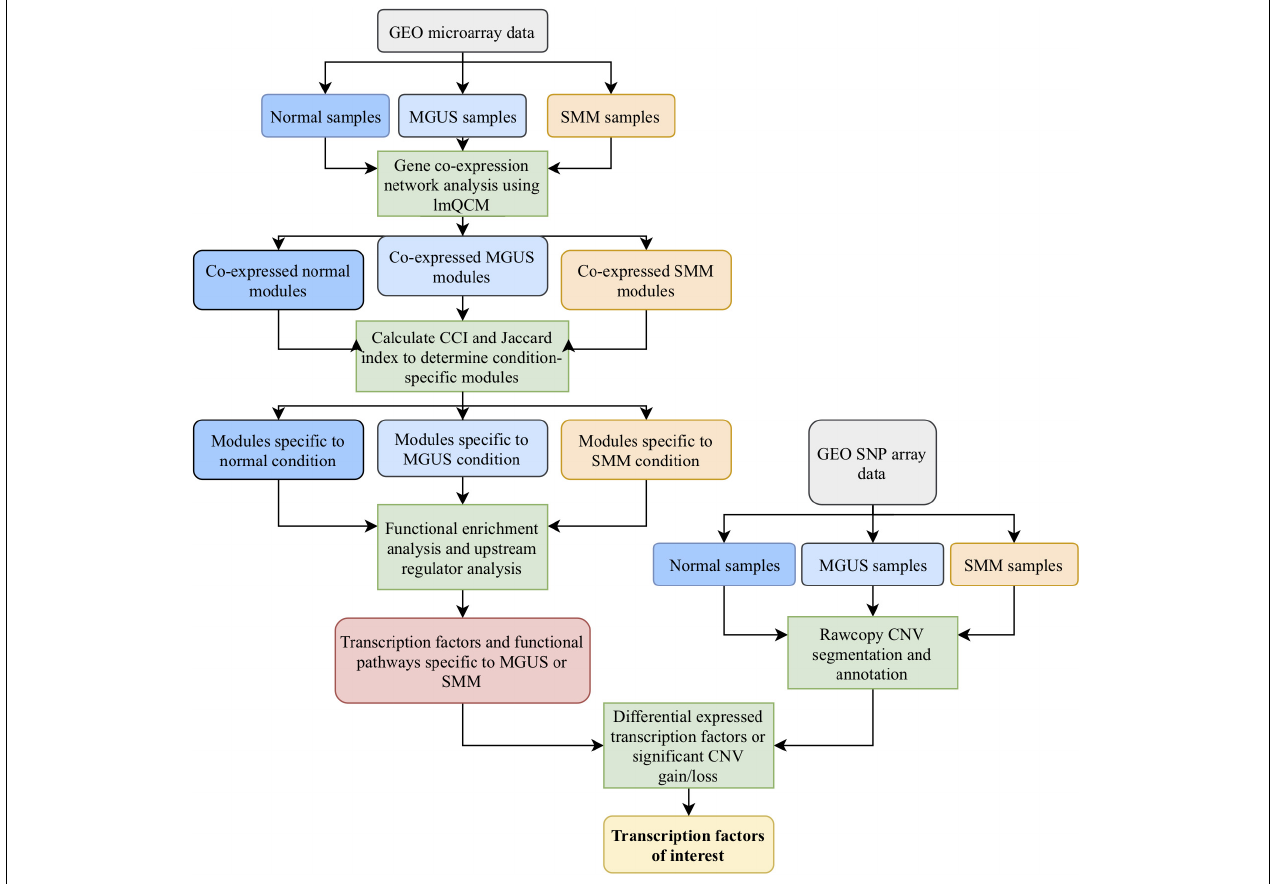
FIGURE 1 | Workflow of the methods employed in this study.